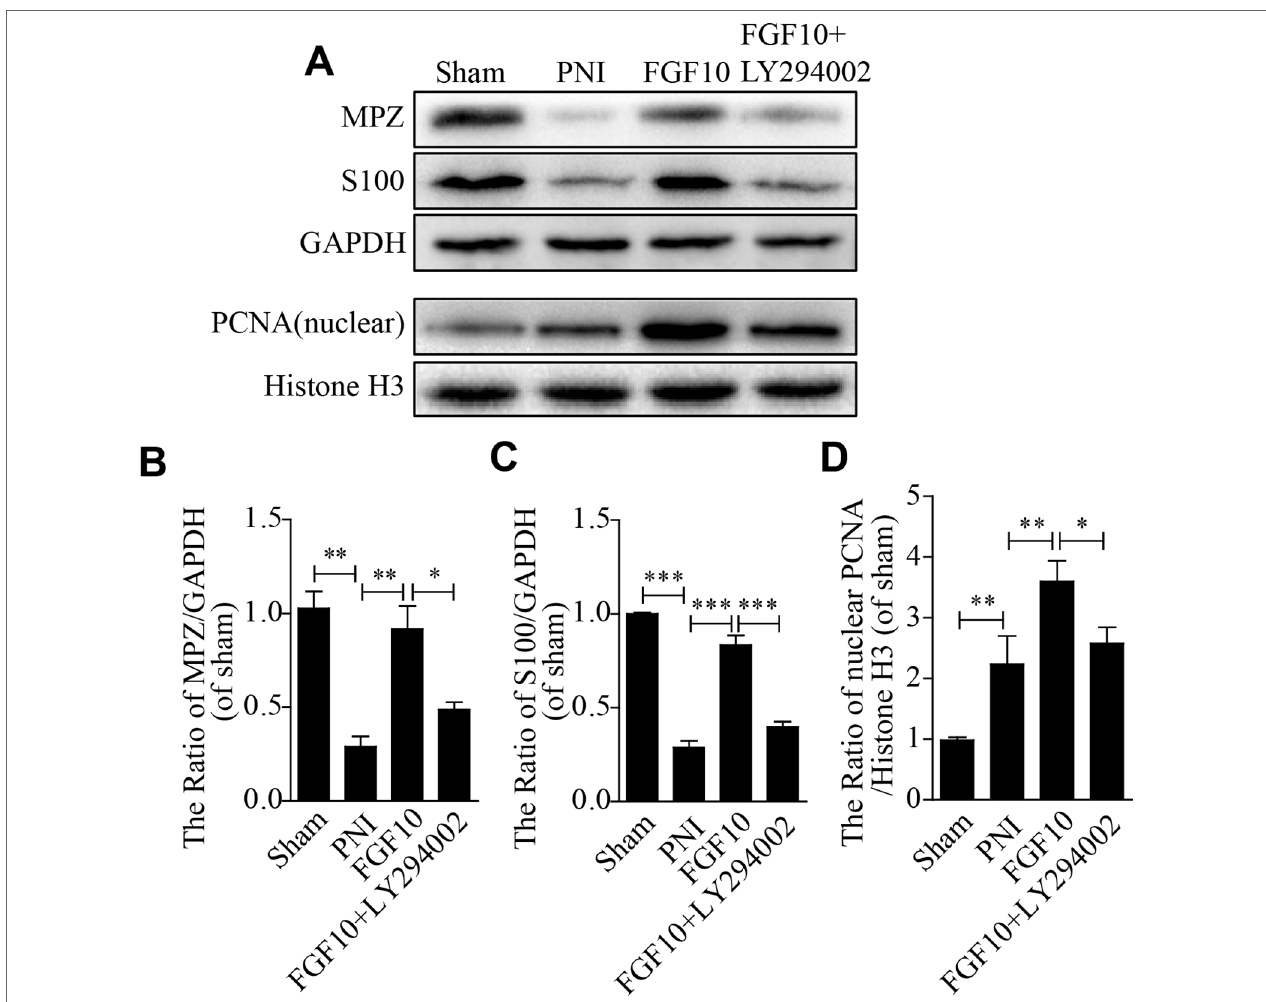
FIGURE 3 | Fibroblast growth factor 10 (FGF10) enhances the expression of functional proteins after sciatic nerve injury. (A – D) Representative immunoblotting images of myelin basic zero (MPZ), S100, and proliferating cell nuclear antigen (PCNA) expression and the quantification of protein levels in sciatic nerve lesions 28 days postinjury. The data are presented as the mean ± SEM, n = 3. Sham group vs peripheral nerve injury (PNI) group: ** P < 0.01, *** P < 0.001. FGF10 group vs PNI group: ** P < 0.01, *** P < 0.001. FGF10 group vs FGF10+LY294002 group: * P < 0.05, ** P < 0.01, *** P <